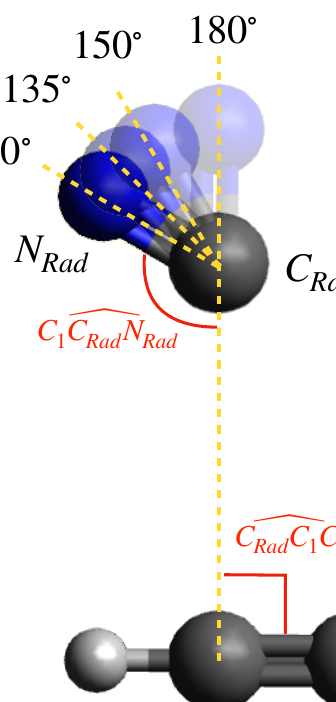
Figure 1. Scheme showing the relevant the approach between the